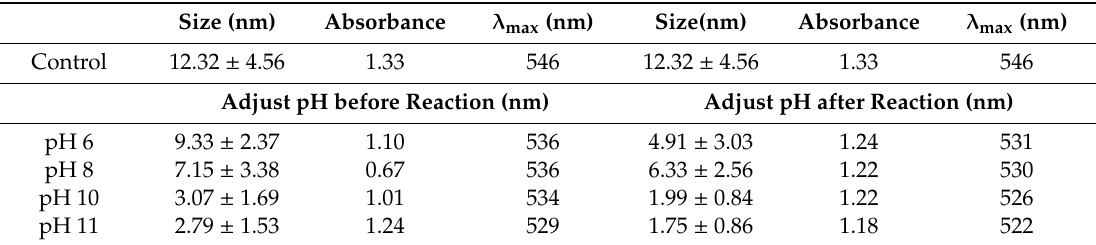
Figure 4. UV-vis spectra of AuNPs solutions obtained from C. sinensis peel at different pHs adjusted after the reaction: (a) control; (b) pH = 6; (c) pH = 8; (d) pH = 10; (e) pH = 11. Table 1. Summary of the peak wavelength ( λ max ), intensity, and size of AuNPs obtained from C. sinensis peel at different experiment condition.